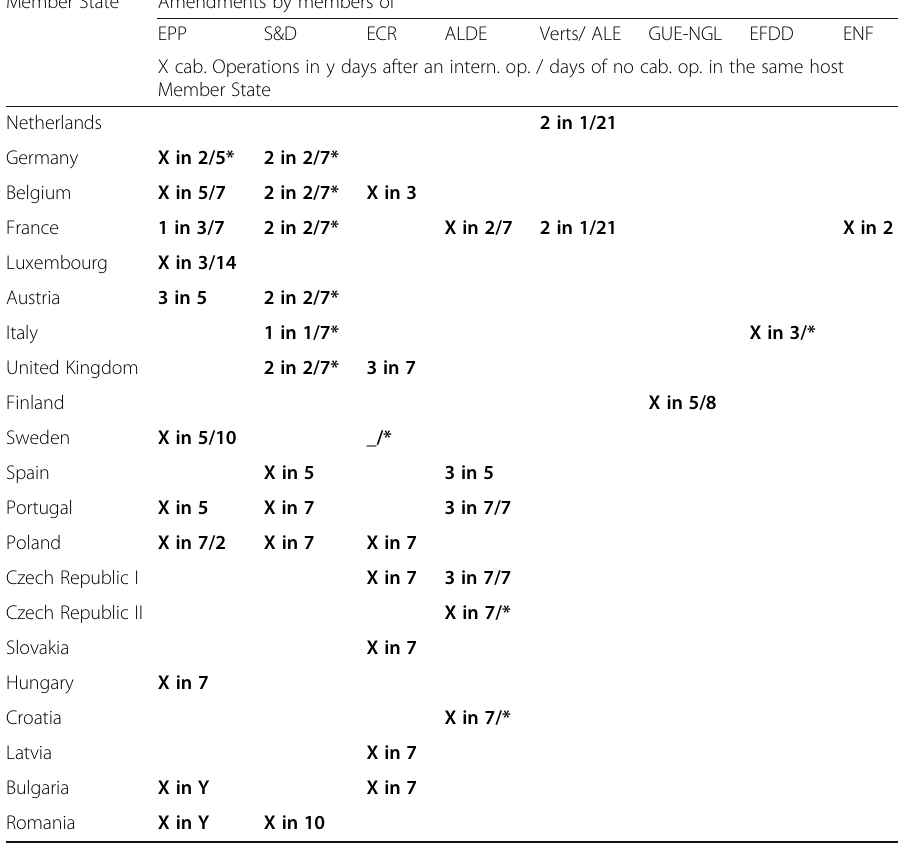
Table 1 Amendments regarding the restriction of days of cabotage Member State Amendments by members